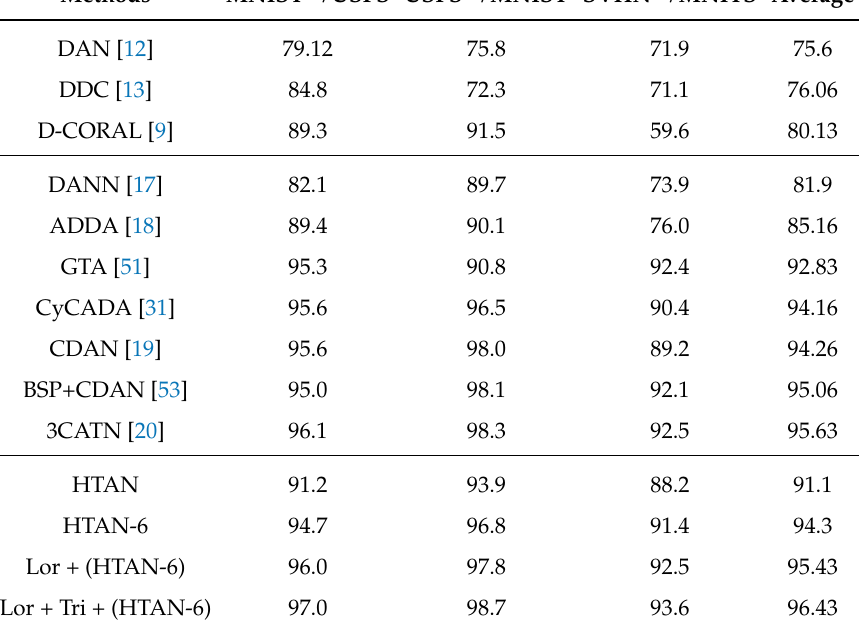
Table 1. Digits Adaptation. Four datasets’ benchmarks in domain adaptation tasks. The result of each is represented by